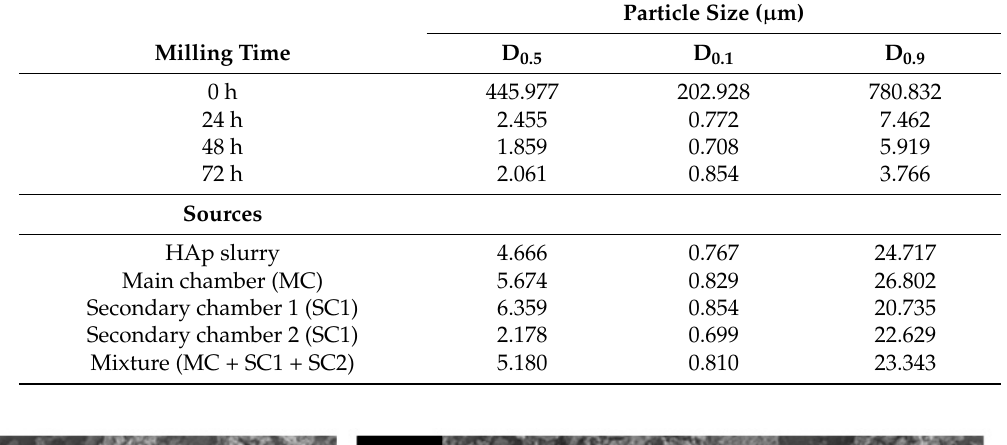
Table 2. Particle sizes of HAp powder after milling and spray-drying process.